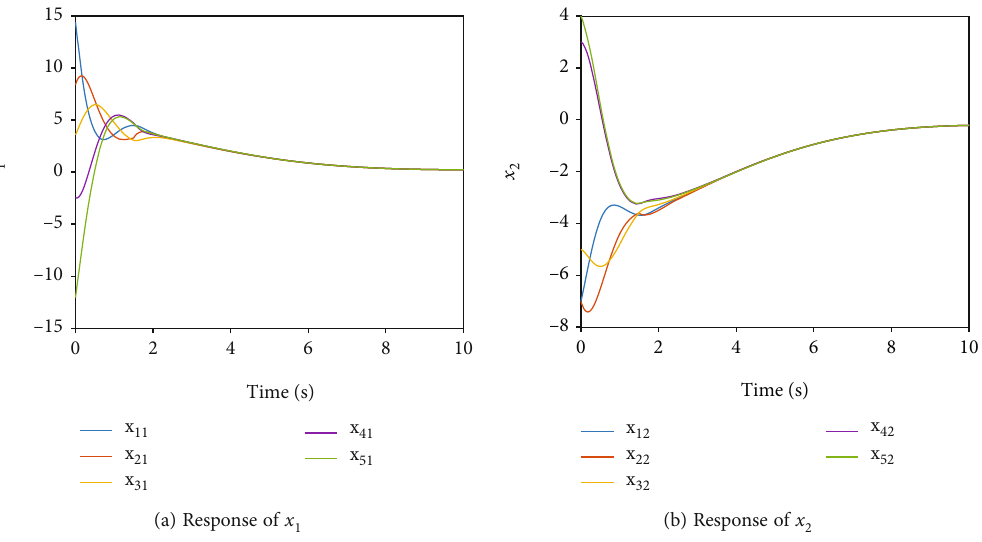
Figure 6: The response of x subject to MDADT switching